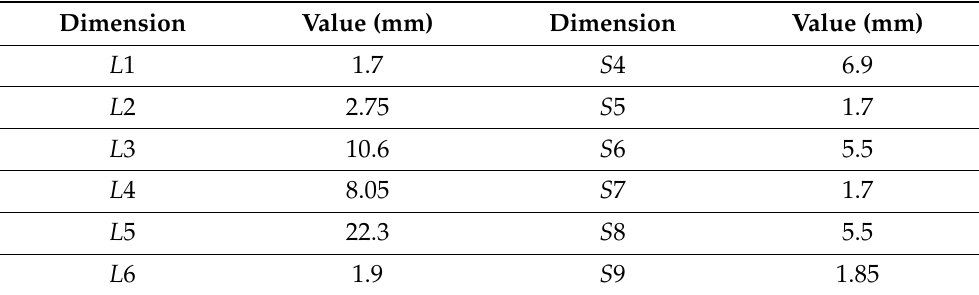
Figure 2. Evolution stages of the antenna element: ( a ) step 1, ( b ) step 2, ( c ) step 3, ( d ) step 4, ( e ) step 5, ( f ) step 6. Table 1. Dimensions of the G-shaped and E-shaped stubs.